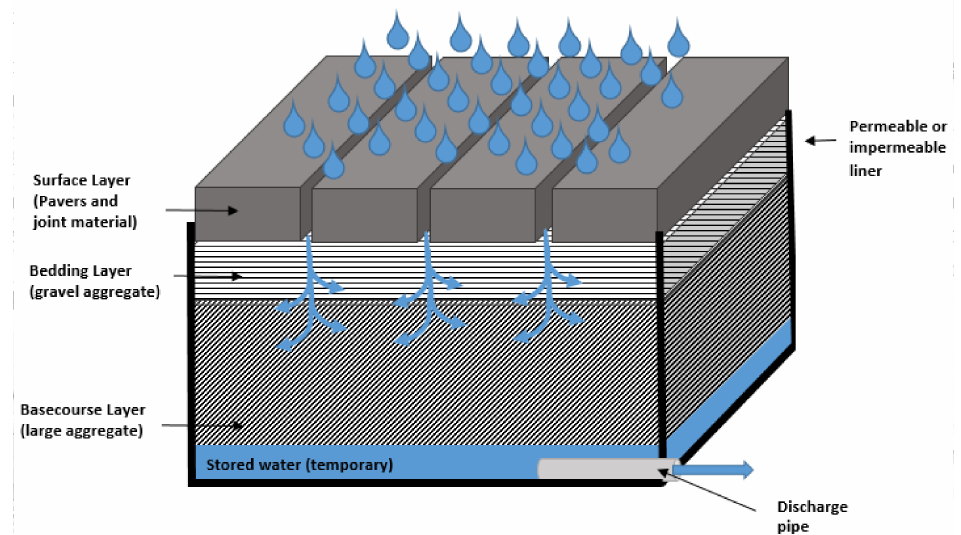
Figure 1. A conceptual diagram of a permeable pavement which detains water prior to the discharge into the conventional urban drainage network or for withdrawal for